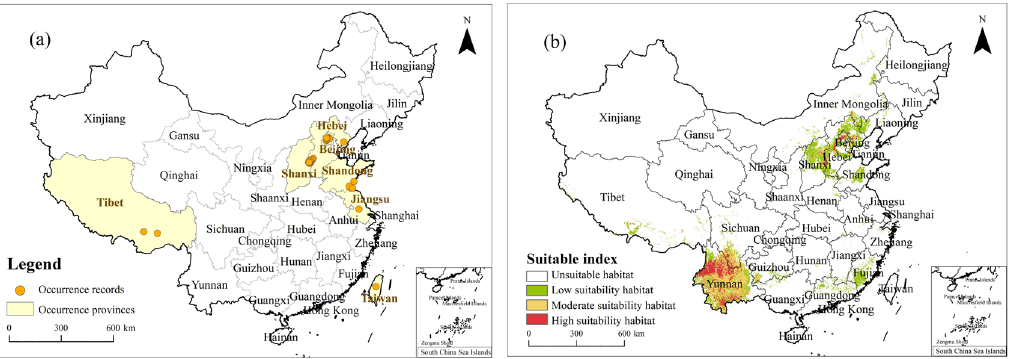
Figure 4. ( a ) Occurrence records of Tagetes minuta in China; ( b ) PGDs (Potential Geographical Distributions) of Tagetes minuta in China under the current climate.